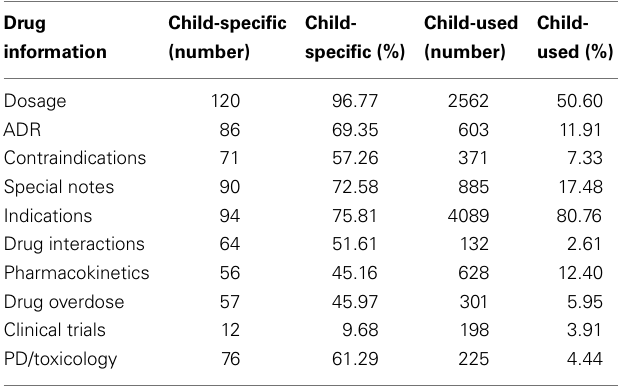
Table 4 | Pediatric label information integrity of prescription medicine .